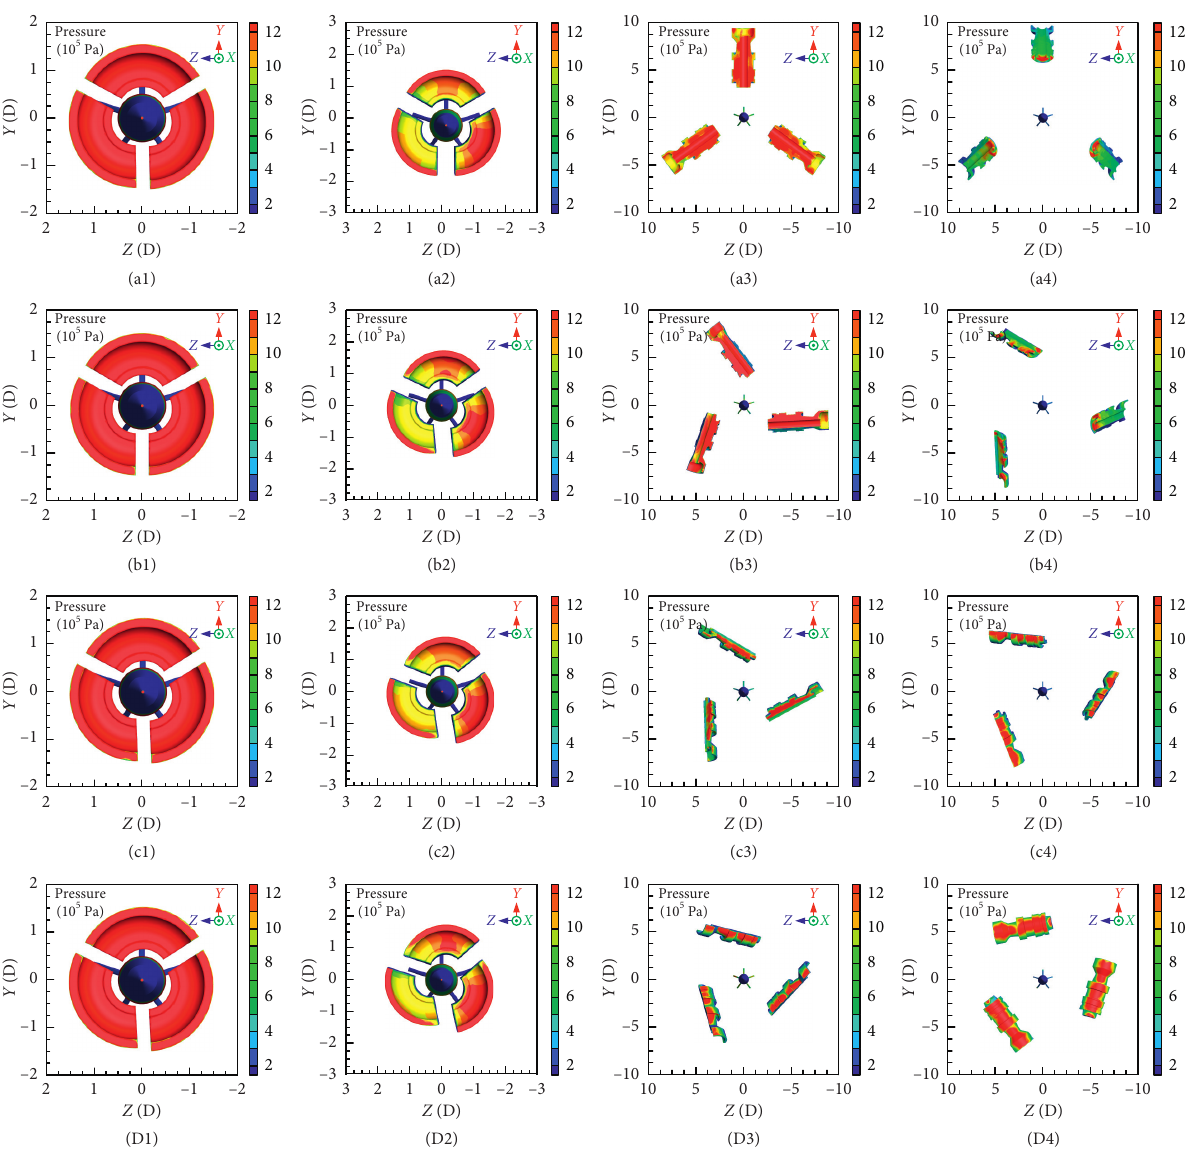
Figure 8: Sabots’ motion of the YOZ -plane. Letters a, b, c, and d, respectively, stand for case 1, case 3, case 5, and case 6. Numbers 1, 2, 3, and 4 are the time of 0.025, 0.1, 1.5, and 1.95ms,